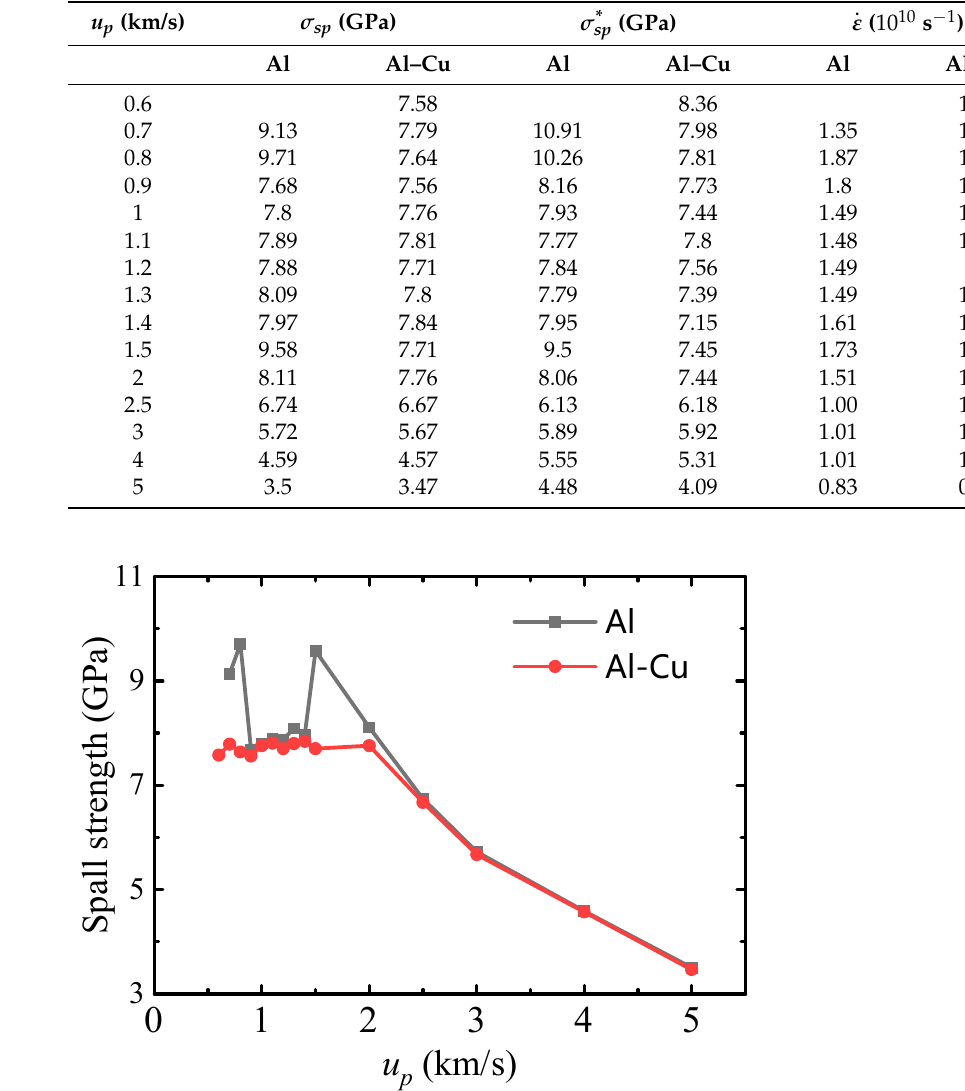
σ σ * ) and Equation (1) ( ). Strain sp